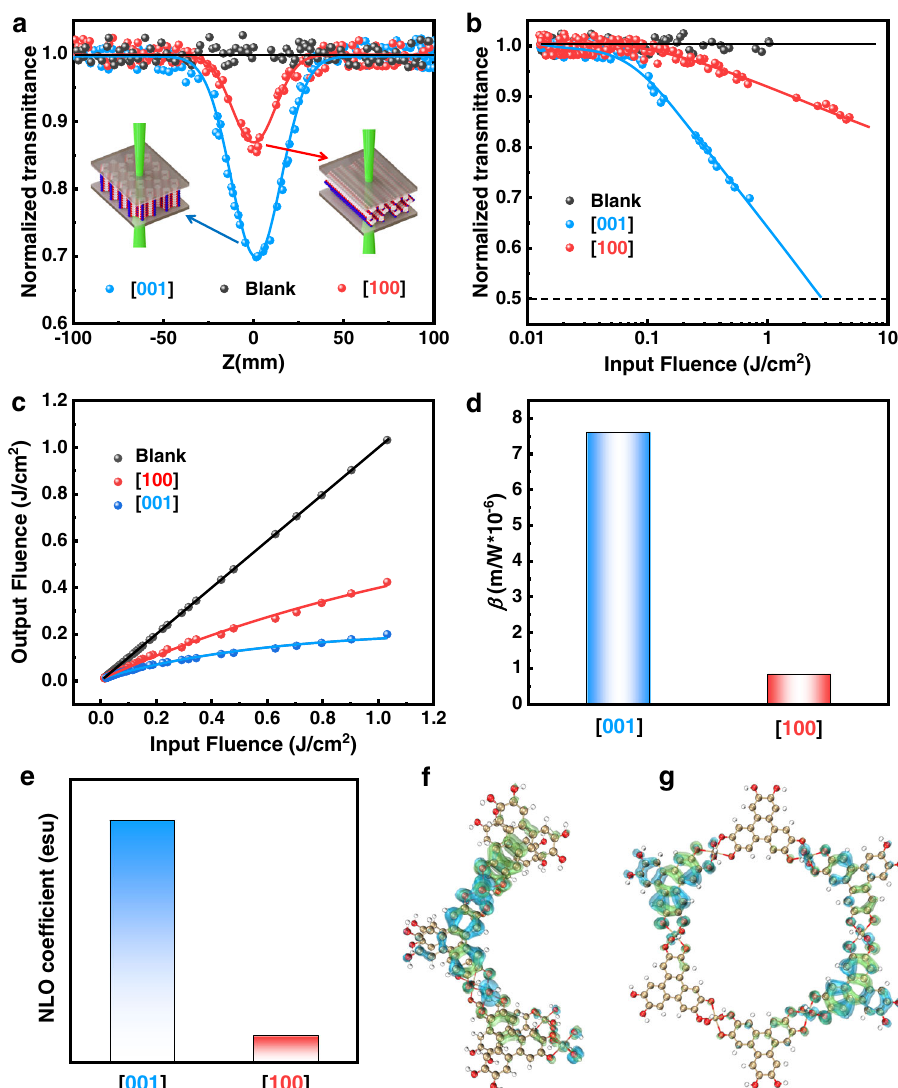
Fig. 4 | Nonlinear optical limiting performance and theoretical calculation of Cu-HHTP fi lms with different orientations. a The open-aperture Z-scan plots of Cu-HHTP [001] and Cu-HHTP [100] fi lms. b Variation in the normalized transmittance asa function of input fl uence . c The curves of output fl uence versus input fl uence.